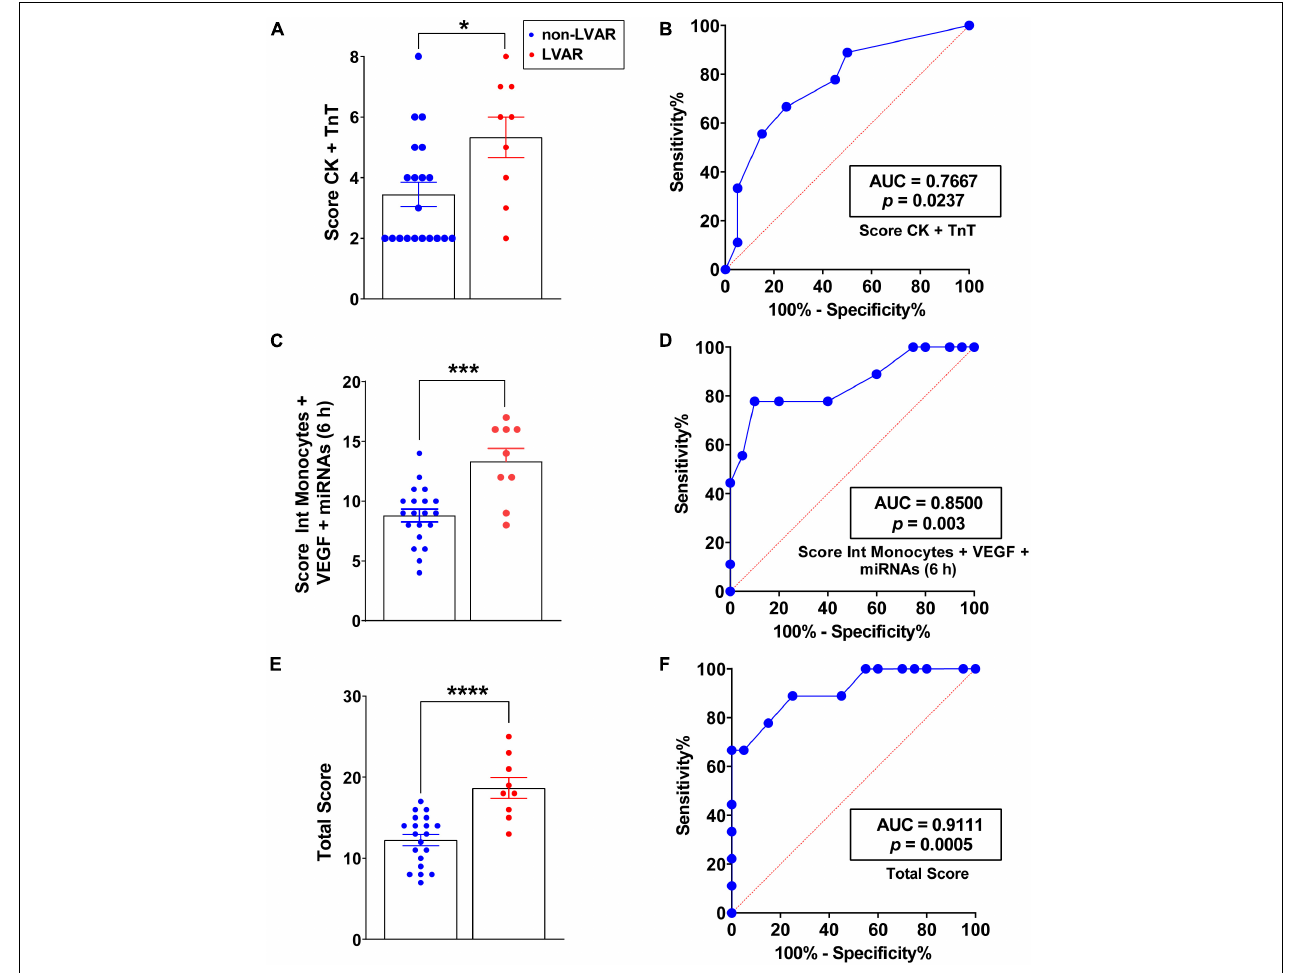
FIGURE 6 | Analysis of the level of the remodeling prediction score in patients with or without LVAR. (A) Bar graphs show the CK and TnT, which is the sum of the score, from 1 to 4, assigned to each level of CK and TnT at 0 h, in non-LVAR (blue dots, n = 20) and LVAR (red dots, n = 9) patients (see section Materials and Methods” and Supplementary Table 3 for more information about formula of the scores and the ranges). (B) ROC analysis with the AUC (values given on the graphs), indicating sensitivity and specificity of the CK and TnT score (A) at 0 h to predict LVAR. (C) Bar graphs show intermediate monocytes, VEGF and miRNAs score at 6 h in non-LVAR and LVAR patients. (D) ROC analysis of intermediate monocytes, VEGF and miRNAs score at 6 h (C) to predict LVAR. (E) Bar graph shows the total score (summary of assigned score to CK and TnT at 0 h, and intermediate monocytes, VEGF and miRNAs at 6 h post-PPCI) in non-LVAR and LVAR patients. (F) ROC analysis with the AUC (values given on the graphs), indicating sensitivity and specificity of the total score to predict LVAR. Values are presented as the means ± SEM. Mann-Whitney (non-parametric) and t -test (parametric) and ROC analysis were performed. (*), (***), and (****) indicate significance at p < 0.05, p < 0.001 and p < 0.0001, respectively. AUC, area under the curve; CK, creatine kinase; LVAR, left ventricle adverse remodeling; miRNAs, microRNAs; PPCI, primary percutaneous coronary intervention; ROC, Receiver-operating characteristics; TnT, troponin-T; VEGF, vascular endothelial growth